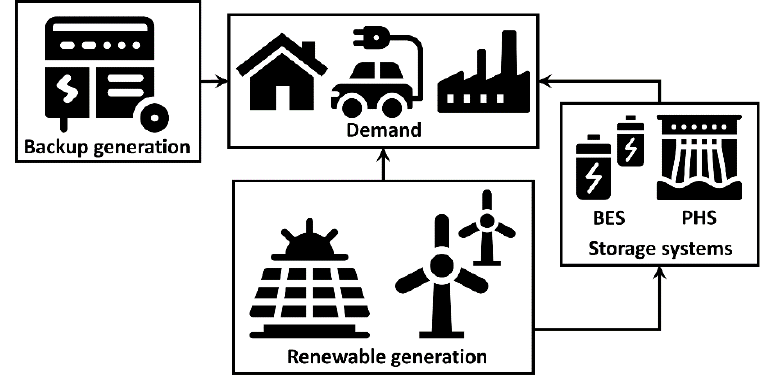
Figure 1. Schematic representation of the isolated MG under study.